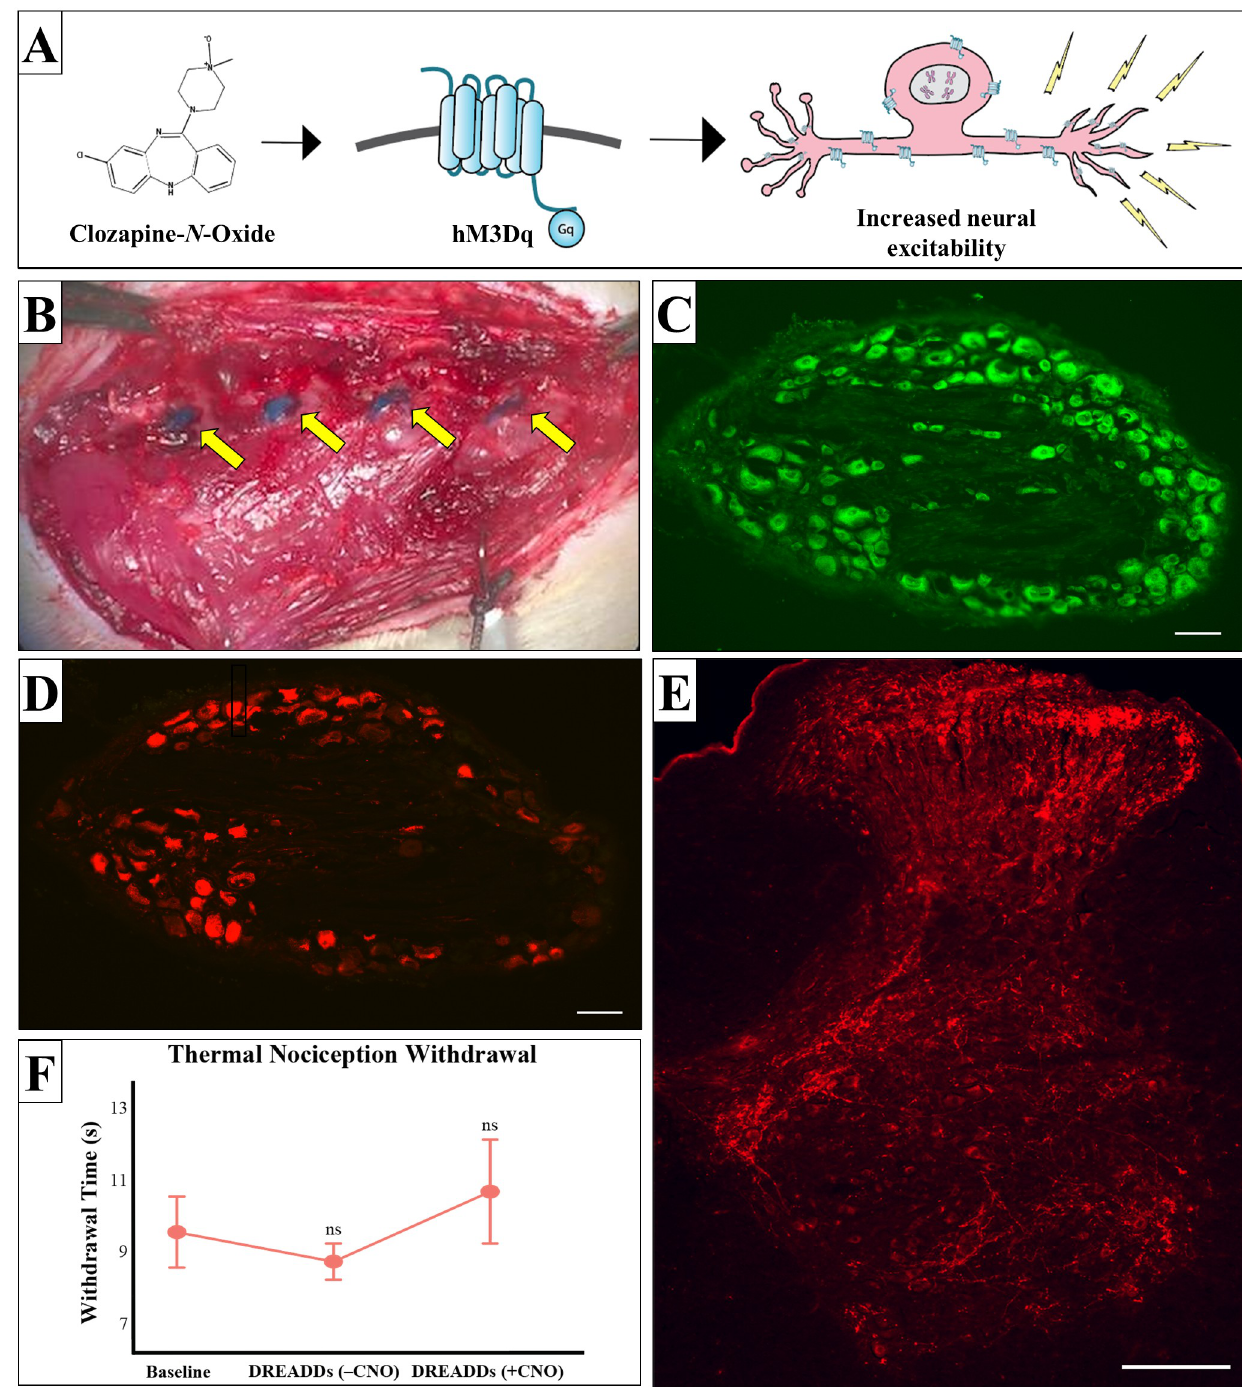
Fig 2. Injection of Designer Receptors Exclusively Activated by Designer Drugs (DREADDs) into rat L2-L5 DRG. (A) Schematic of hM3Dq (excitatory) DREADDs. DREADDs are a transmembrane protein activated by its chemical actuator clozapine-N-oxide (CNO). Potential downstream neuronal effect of hM3Dq DREADDs is increased neuronal excitation. (B) Photograph of L2-L5 DRG injection in wild type Sprague Dawley rats (from right to left; yellow arrows). Injected DRGs (blue) are visualized with Fast Green FCF. (C, D) Immunostaining shows we achieve approximately 42% DREADDs transfection in rat DRGs. Fluorescent Nissl shows total DRG neurons (green; C) and dsRed amplified mCherry in virally transfected neurons (red; D). C and D are sections that are 20 um apart. Scale bar, 100 um. (E) Immunostaining in corresponding lumbar spinal cord of DREADDs injected DRGs. DREADDs positive axons can be observed extending throughout the dorsal and ventral horn. Scale bars 200um. (F) Hargreaves paw withdrawal response times to thermal nociception